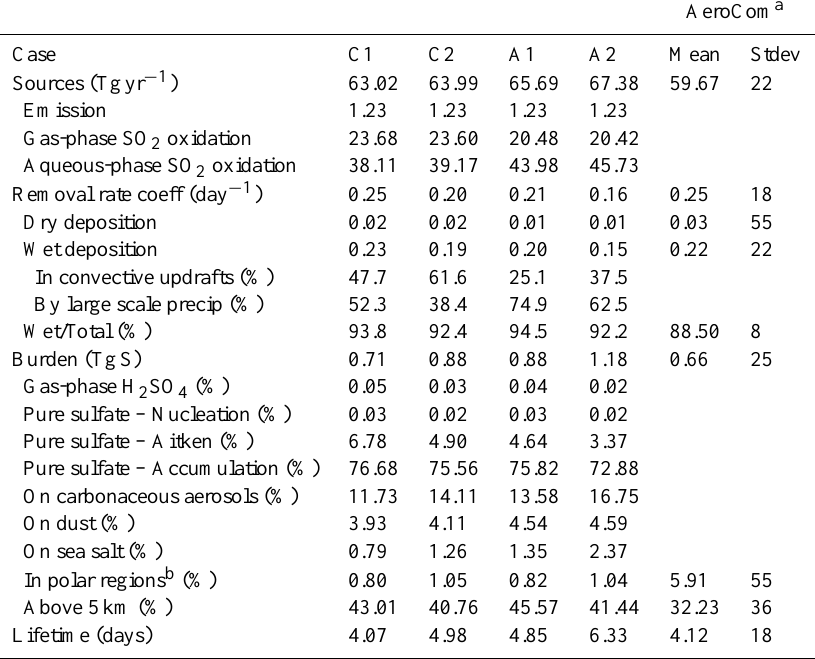
Table 4. Global budget of sulfate